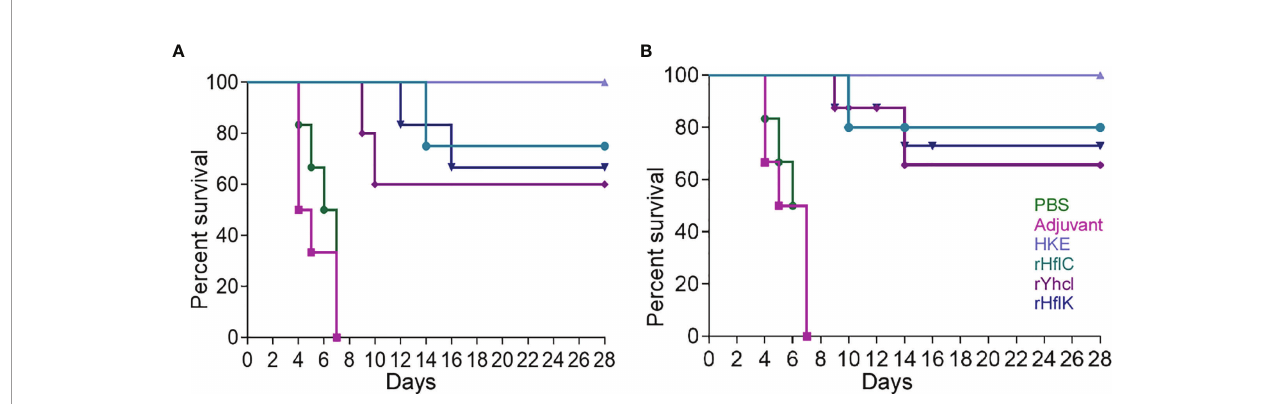
FIGURE 6 | Survivability of the immunized mice (A) and fi sh (B) ( Labeo rohita ) against virulent E. tarda strain ED-BDU1 and the survival curves were compared using log-rank analysis. The number of survived animals in different day intervals (0 – 28) after the challenge was estimated as Mean ± SD to plot the graphs. Two-tailed P value was determined by Fisher exact test in comparison to the result of different groups observed as follows: PBS, Adjuvant, Heat Killed Edwardsiella (HKE), rH fl C, rH fl K, rYhcI. x-axis: Immunization days, y-axis: percent